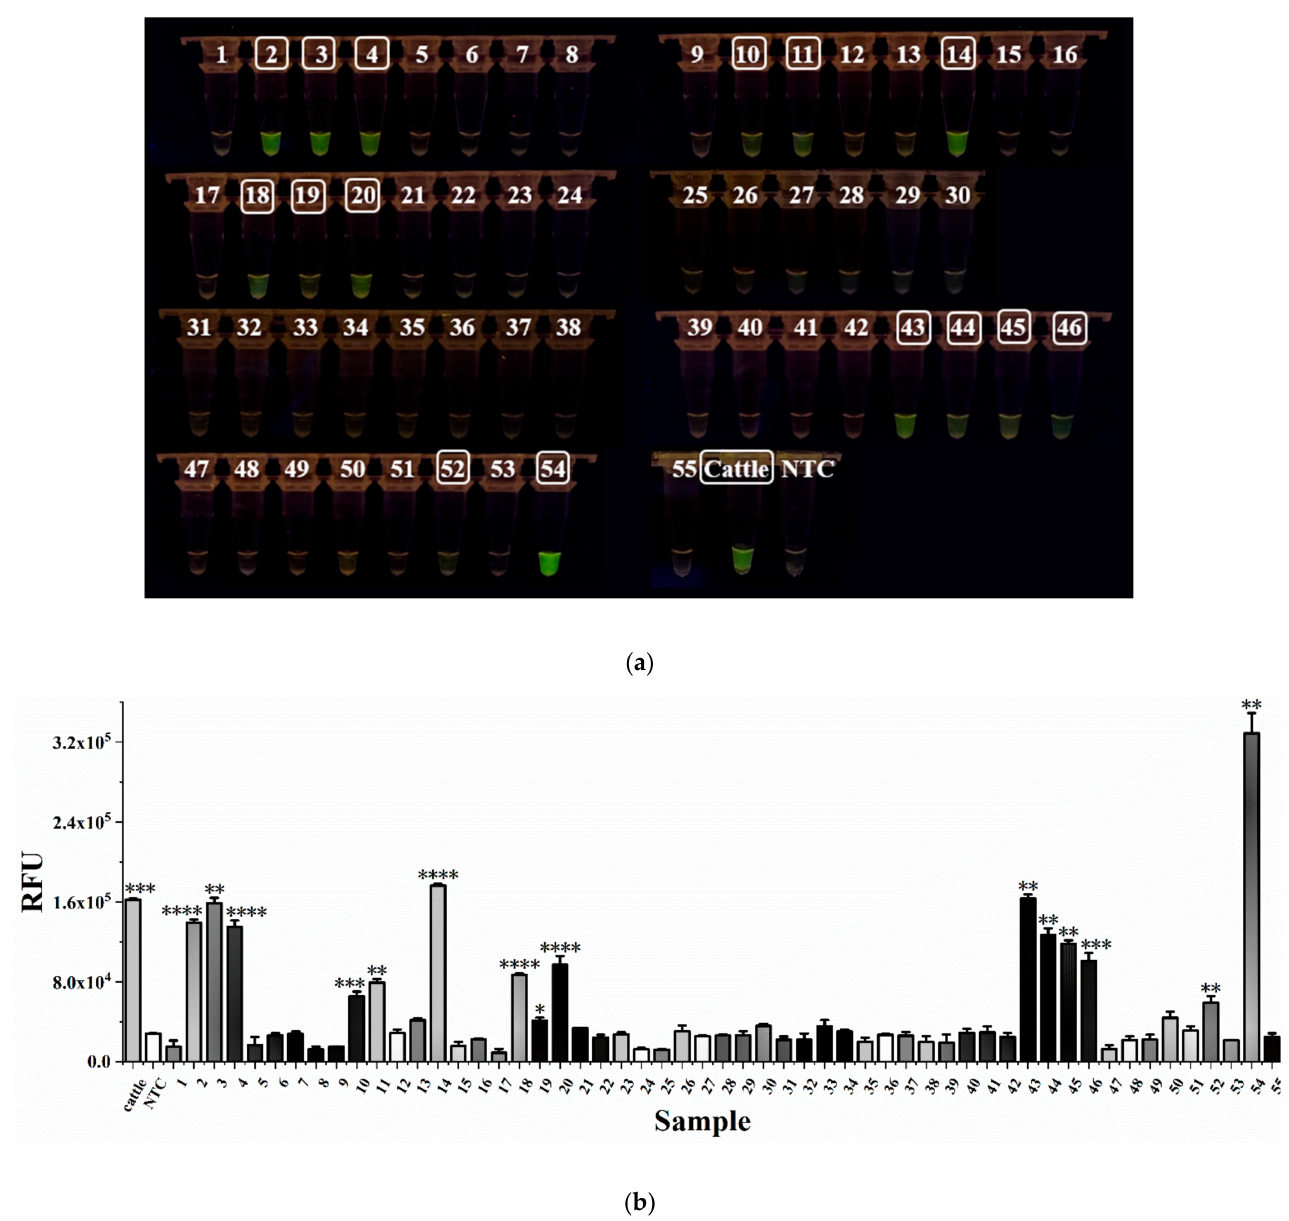
Figure 5. The results of 55 goat milk powder products tested by RPA-CRISPR/Cas12a assay. ( a ) The result of naked-eye observation. The white boxes show that 15 samples were found to contain cattle-derived ingredients. ( b ) The result of data analysis. The unpaired two-tailed Student’s t-test was used to analyze the statistical significance of the sample fluorescence value and NTC (* p < 0.05, ** p < 0.01, *** p < 0.001, **** p < 0.0001). NTC: negative control; Cattle: positive